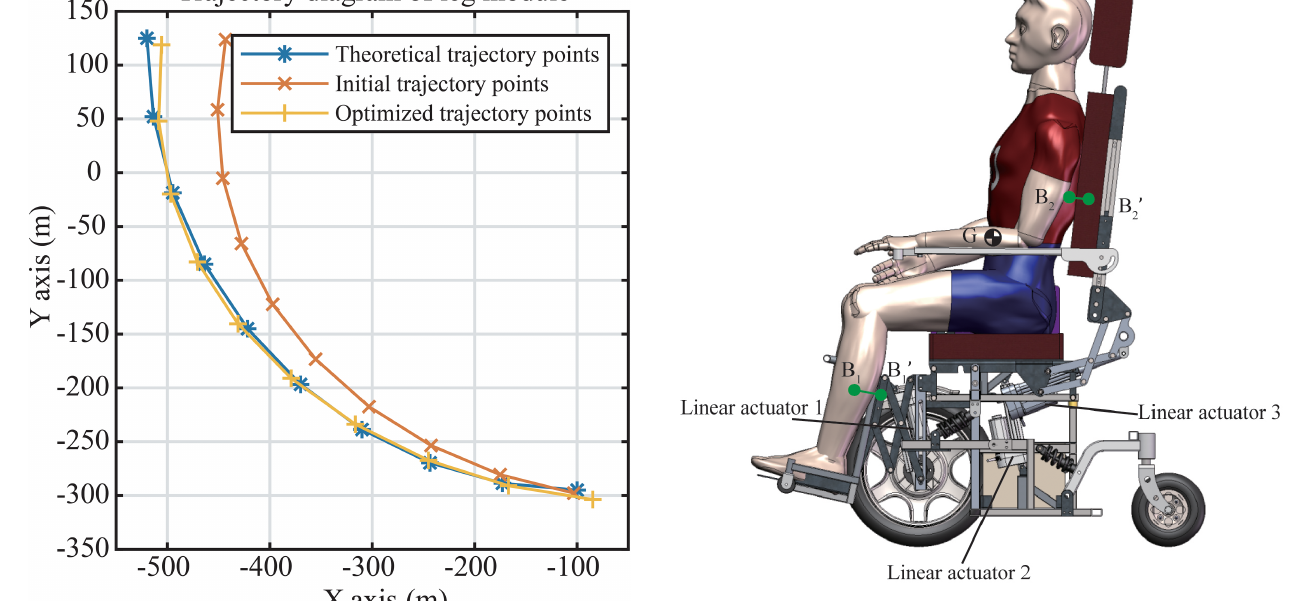
Figure 14. Schematic diagram of the